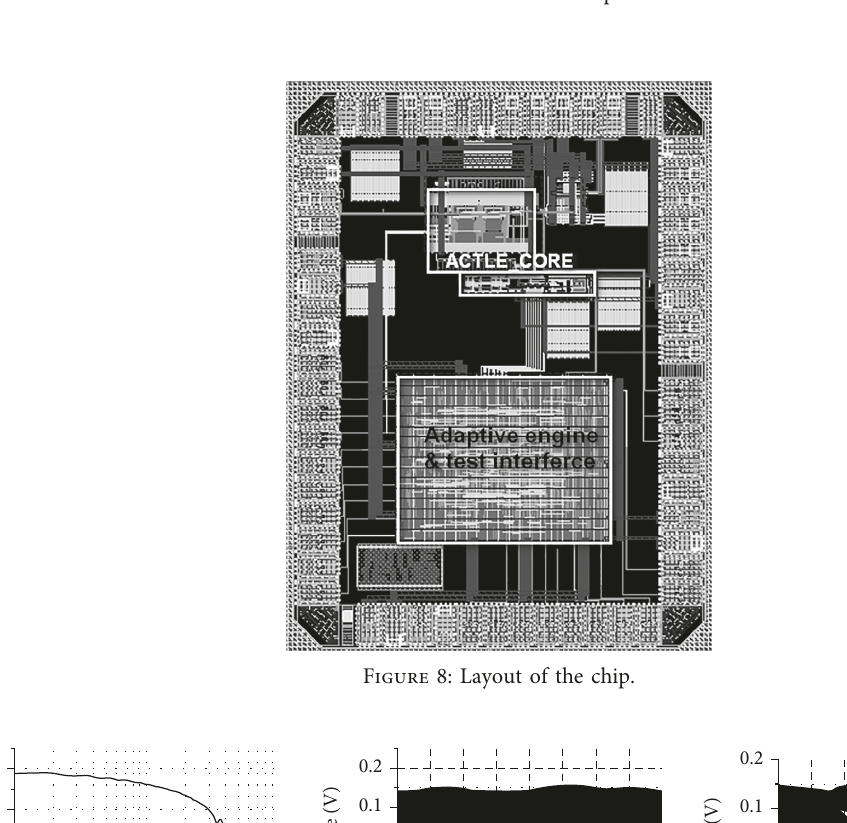
Figure 7: Circuit of full differential comparator and DAC.